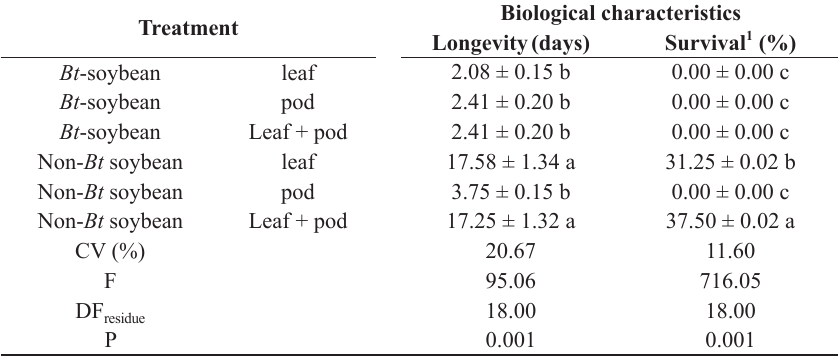
Larval development of Heliothis virescens (< 24-h old) fed with vegetative and reproductive Bt -soybean structures and its isogenic non- Bt , under controlled laboratory conditions [25 ± 2 °